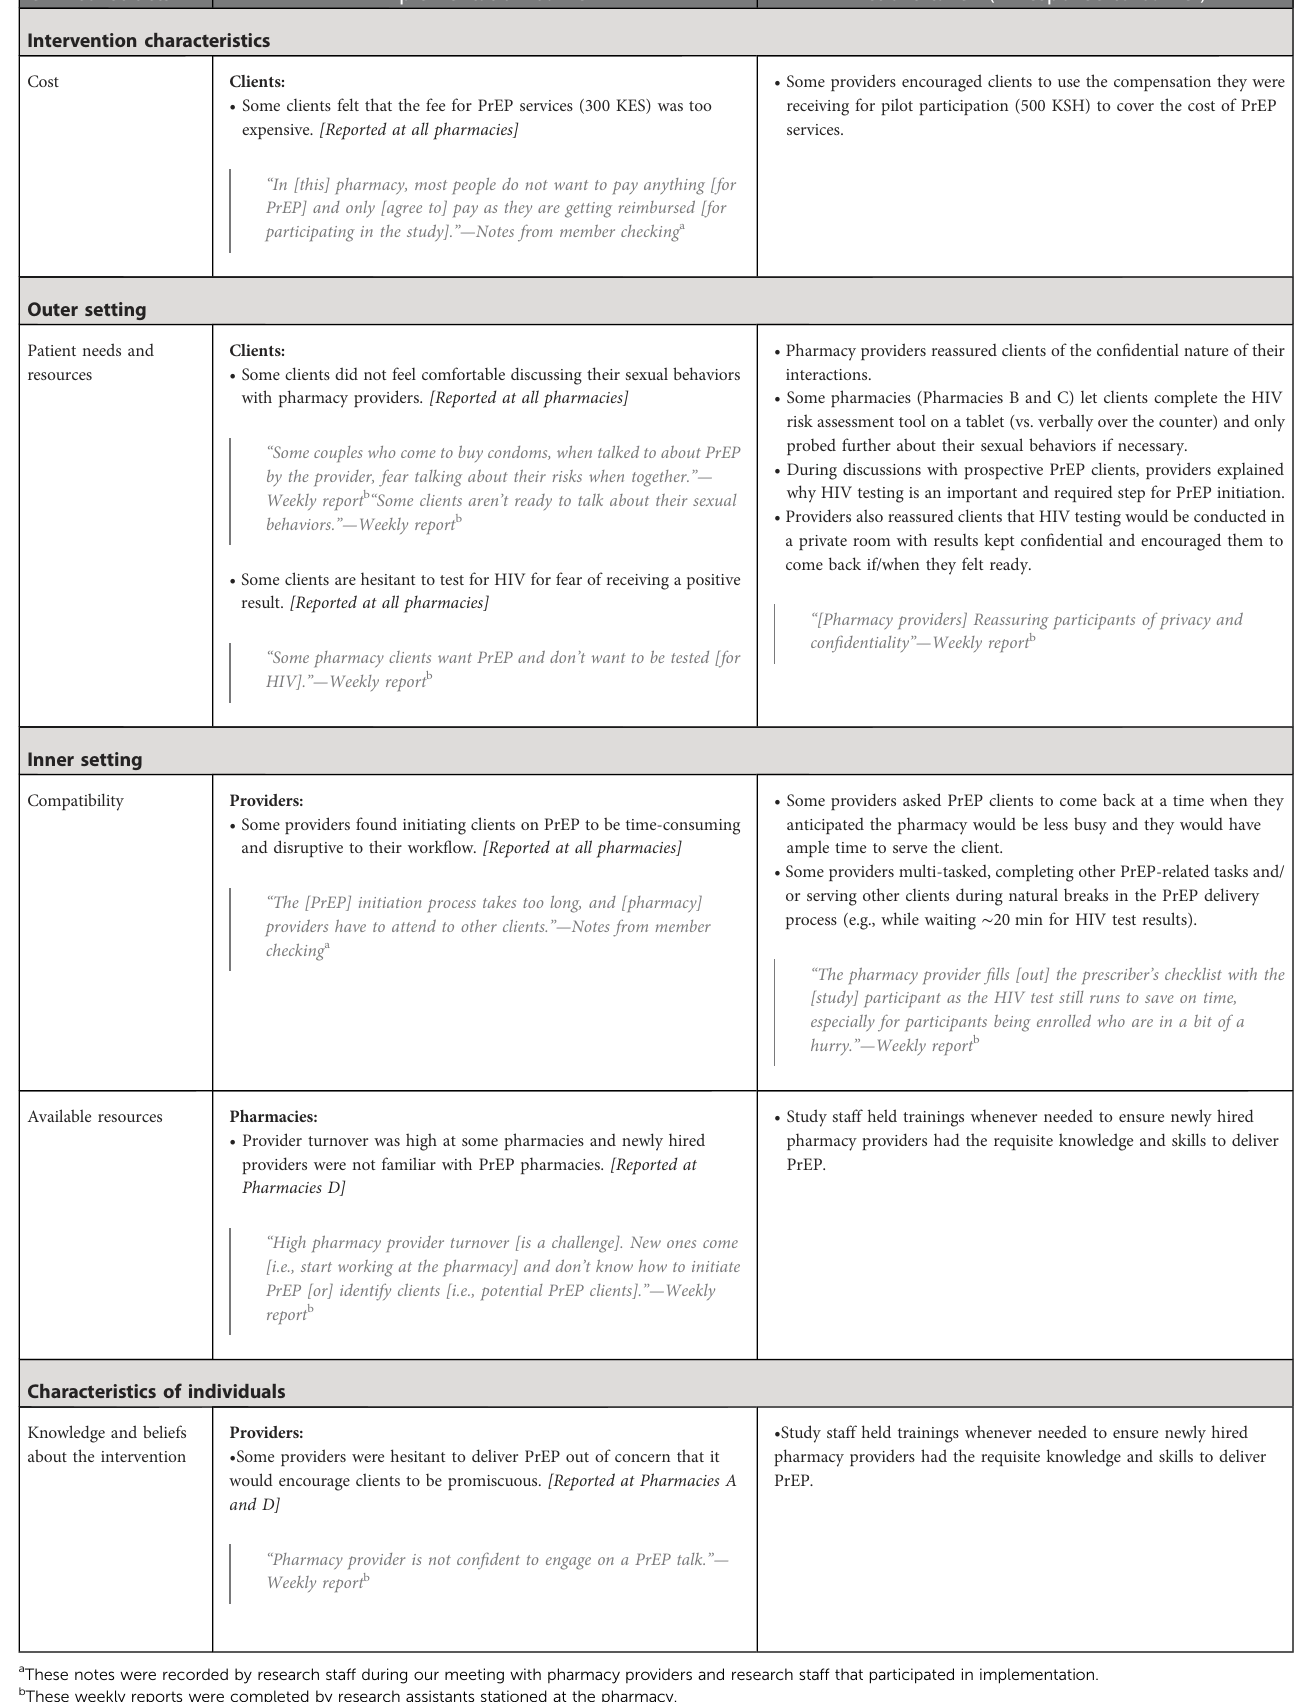
TABLE 1 Early implementation barriers to pharmacy-delivered PrEP services and actions taken in response. CFIR constructs Implementation barrier Actions taken (in response to